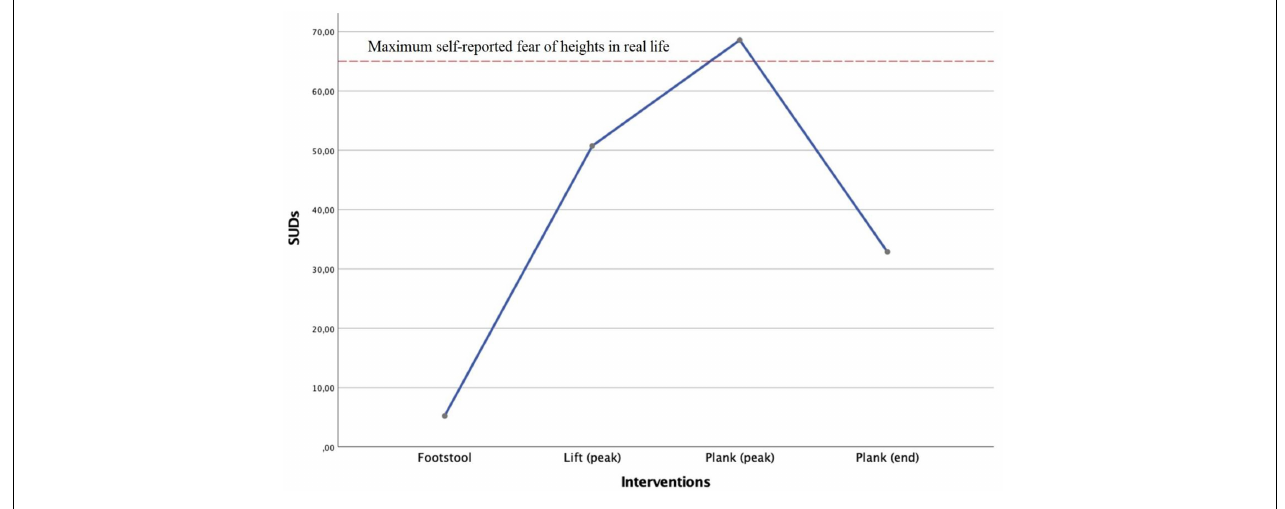
FIGURE 3 | Visualization of SUD ratings throughout the interventions for all participants.